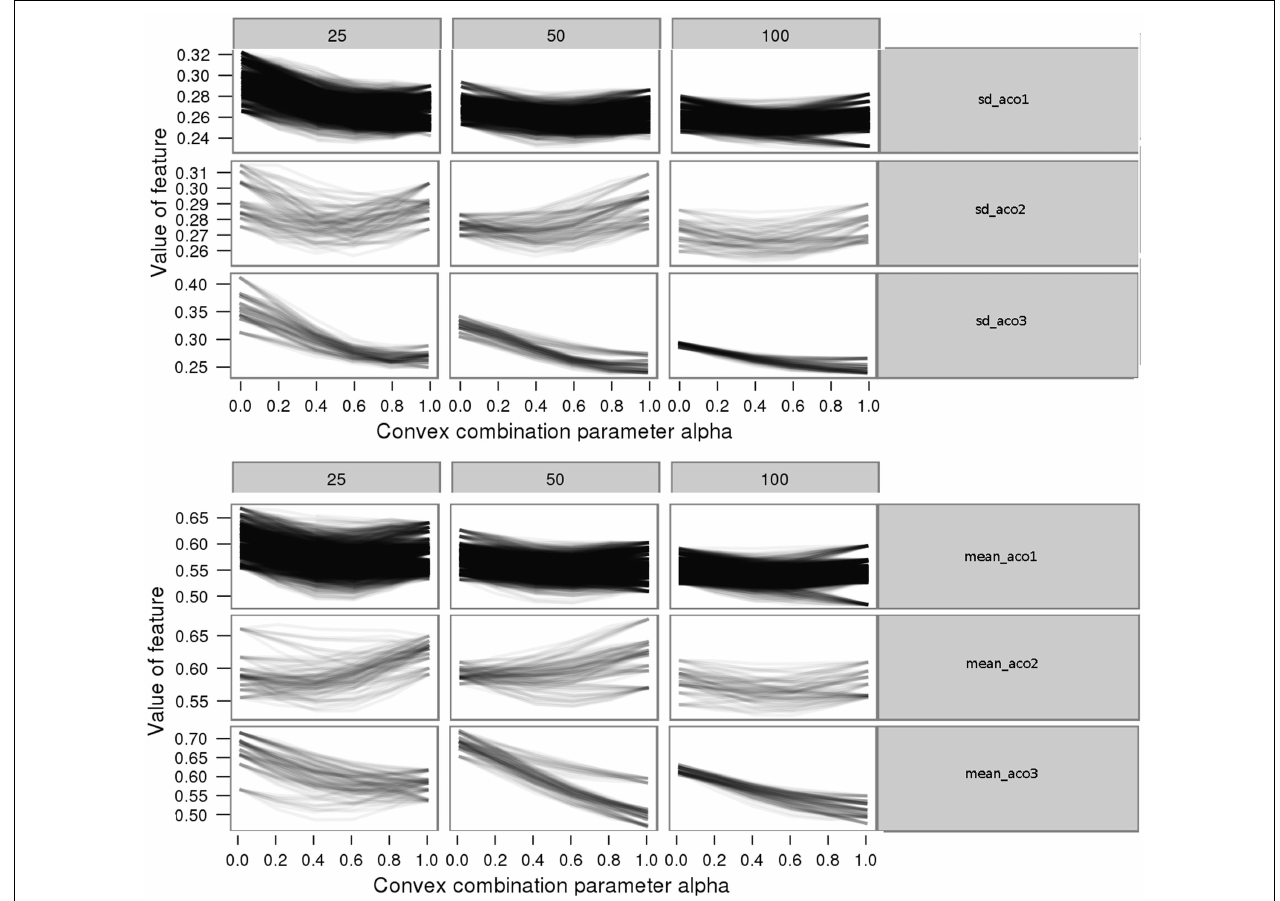
FIGURE 5 | Feature variation with instance difficulty for mean (top) and SD (bottom) of distances for the three parameter settings 1 (top), 2 (middle), and 3 (bottom) .